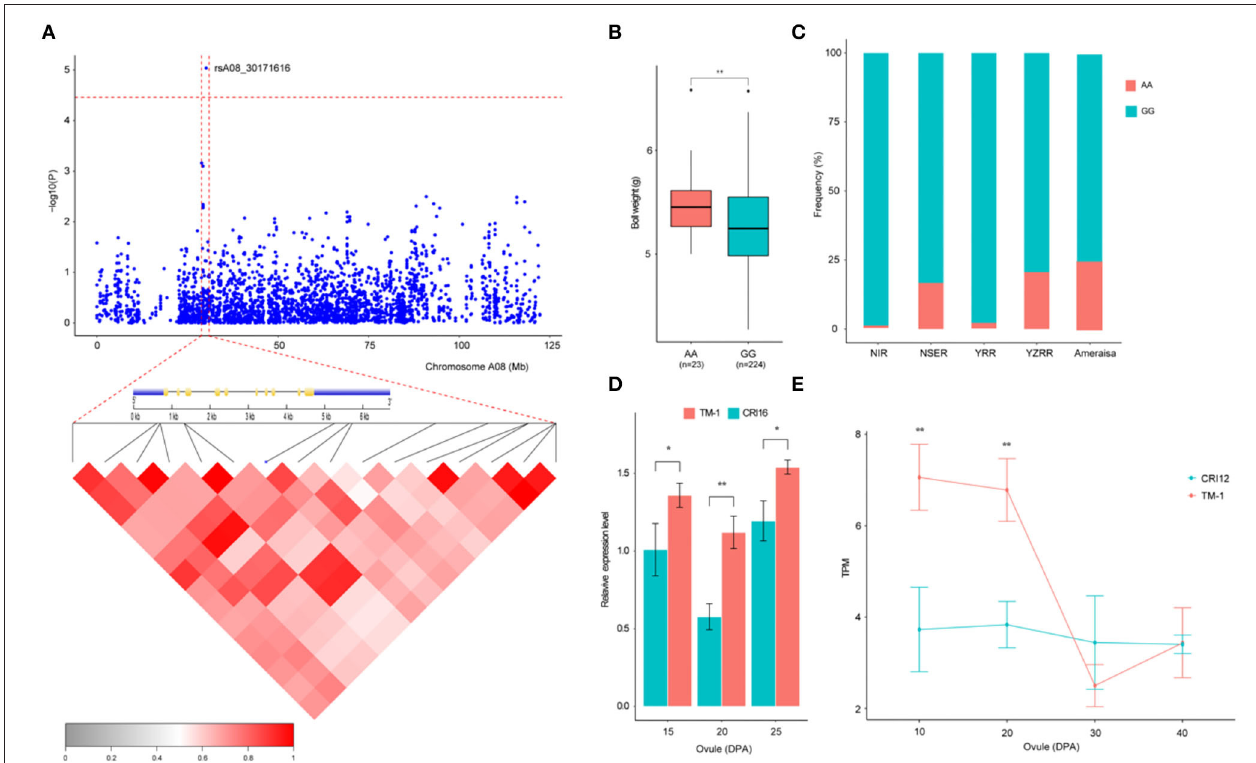
FIGURE 4 | Variation analysis of the boll weight-related gene Ghir_A08G009110 on candidate region. (A) Local Manhattan plots for BW-related genes on chromosome A08 and LD heatmap for the candidate region within the peak region of rsA08_30171616, including the exon–intron structure of Ghir_A08G009110 . (B) Box plots for BW between the two haplotypes mentioned above (** P < 0.01, * P < 0.05). (C) Differentiation of the genetic diversity distribution of the favorable haplotype for rsA08_30171616 in five geographic areas. (D) Expression level analysis of Ghir_A08G009110 between “TM-1” (red) and “CRI16” (green) during ovule developmental stages (15, 20, and 25 DPA) by qRT-PCR (** P < 0.01, * P < 0.05). (E) Expression abundance analysis of Ghir_A08G009110 between “TM-1” (red) and “CRI12” (green) during ovule developmental stages (10, 20, 30, and 40 DPA) by RNA-seq (** P < 0.01, * P <